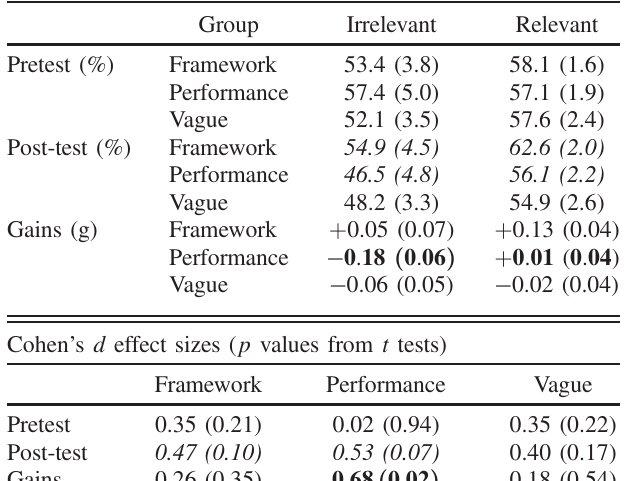
TABLE V. Top: Average CLASS pretest and post-test percent- ages of expertlike scores and normalized gains, comparing students who perceived relevance vs students who did not. Standard errors are in parentheses next to means; please see Table I for respective sample sizes. Bottom: Cohen ’ s d values and t -test p values for comparisons between relevant and irrelevant views. Adapted from Table 5 in Ref.